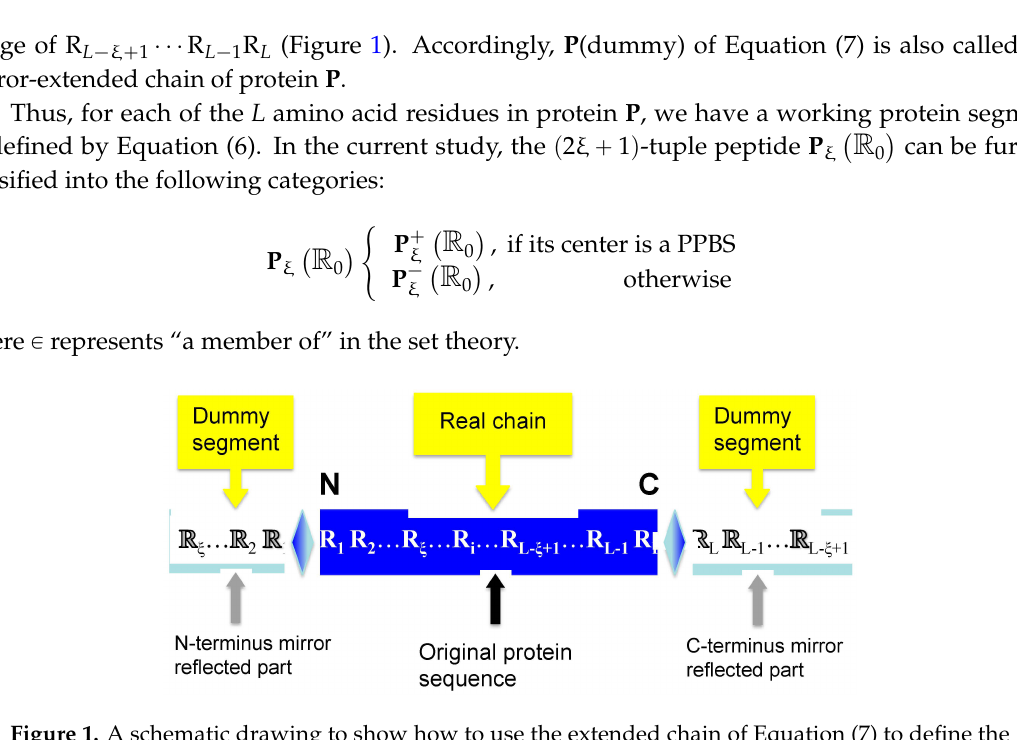
Figure 1. The proposed framework inspired by HVS.